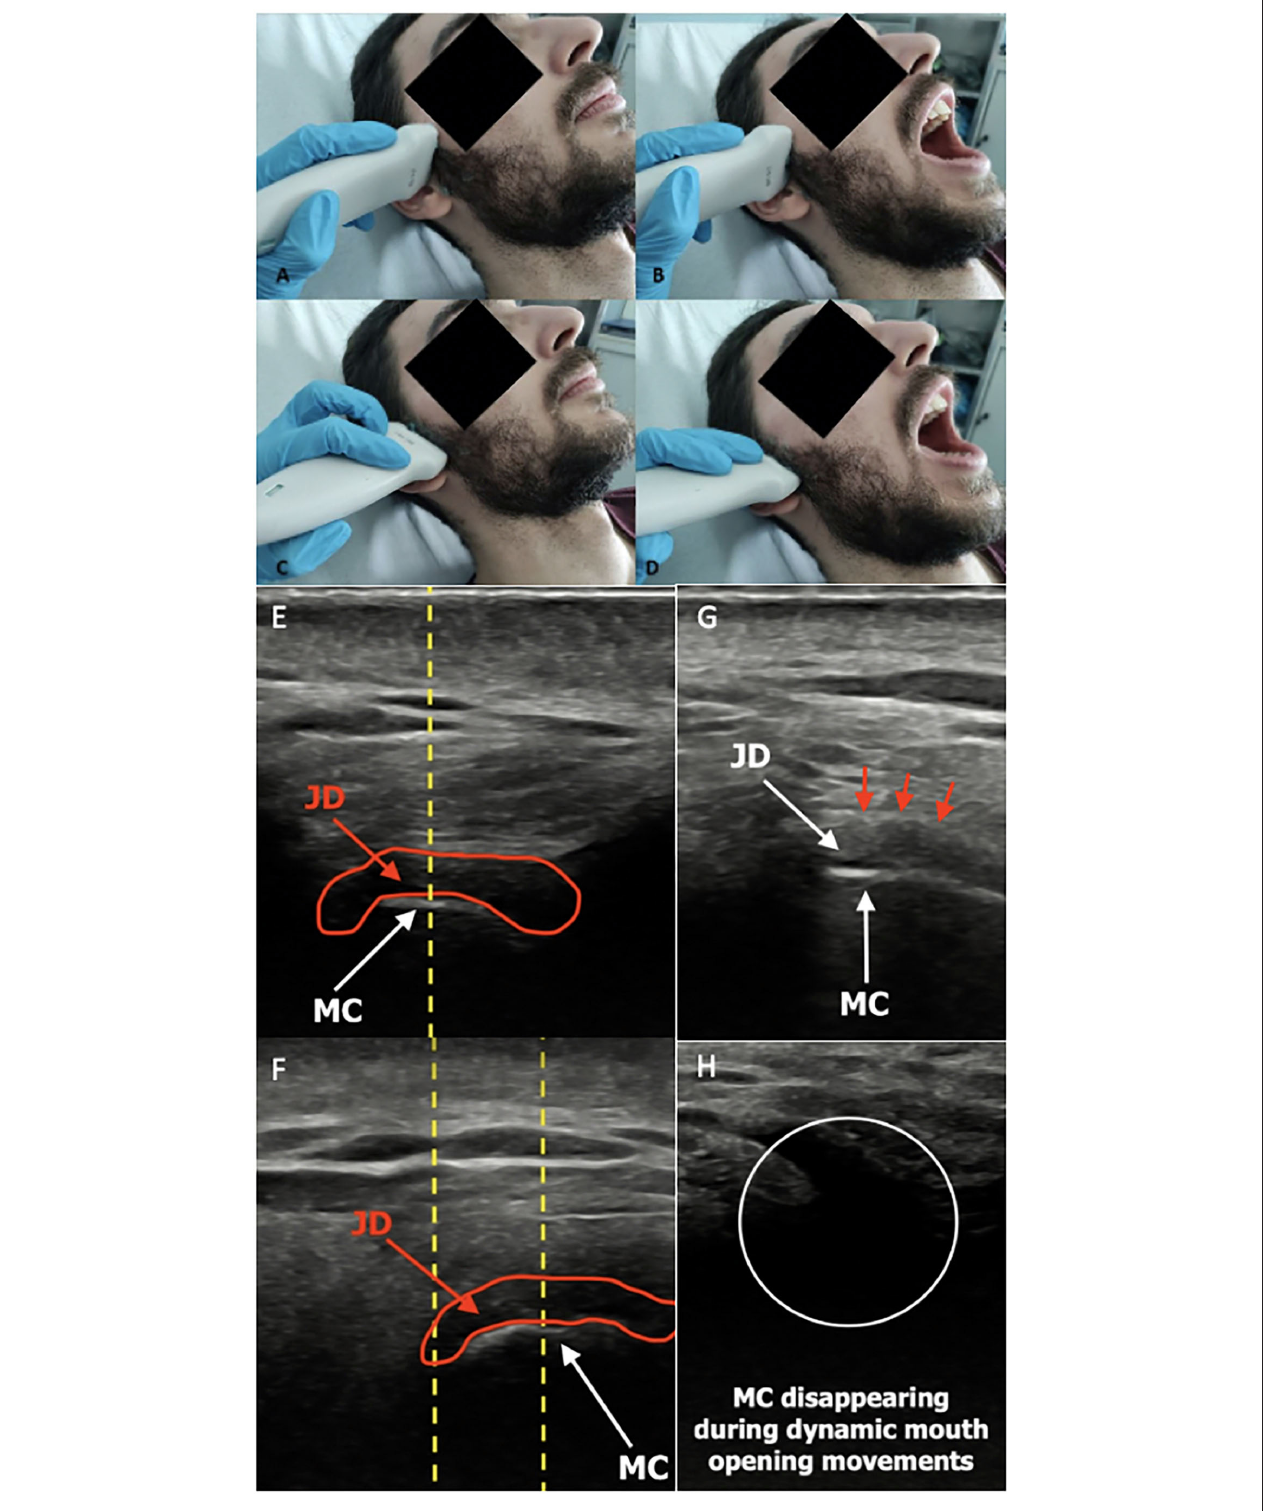
FIGURE 3 | Conventional US transducer positions are parallel to the Frankfort horizontal plane (a plane connecting the highest point of the opening of the external auditory canal with the lowest point on the lower margin of the orbit) in closed-mouth (A) position and open-mouth (B) position, as well as parallel to the ramus of mandible, both in closed-mouth (C) and open-mouth (D) positions. Normal ultrasound image of TMJ in transverse sections in closed- (E) and open-mouth